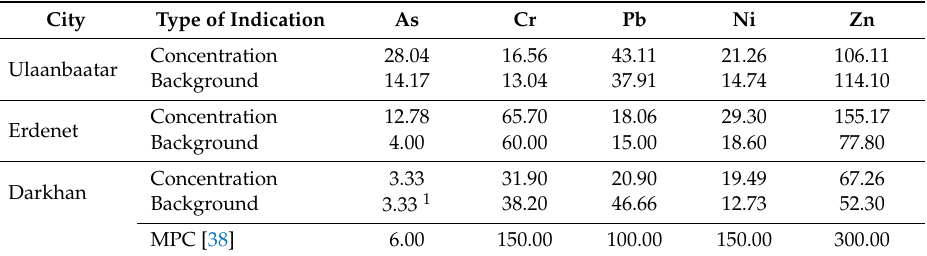
Table 4. Heavy metal mean concentration with their background values in the soil of three di ff erent cities from